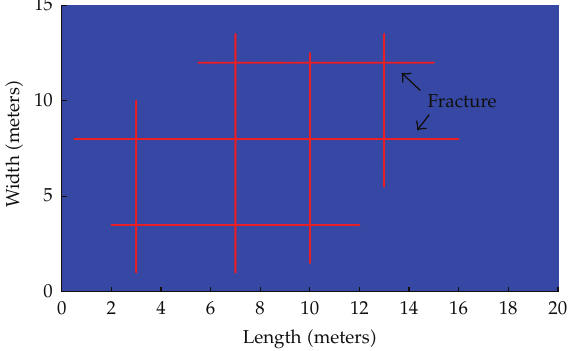
Figure 7: Distribution of fractures: Example 3.